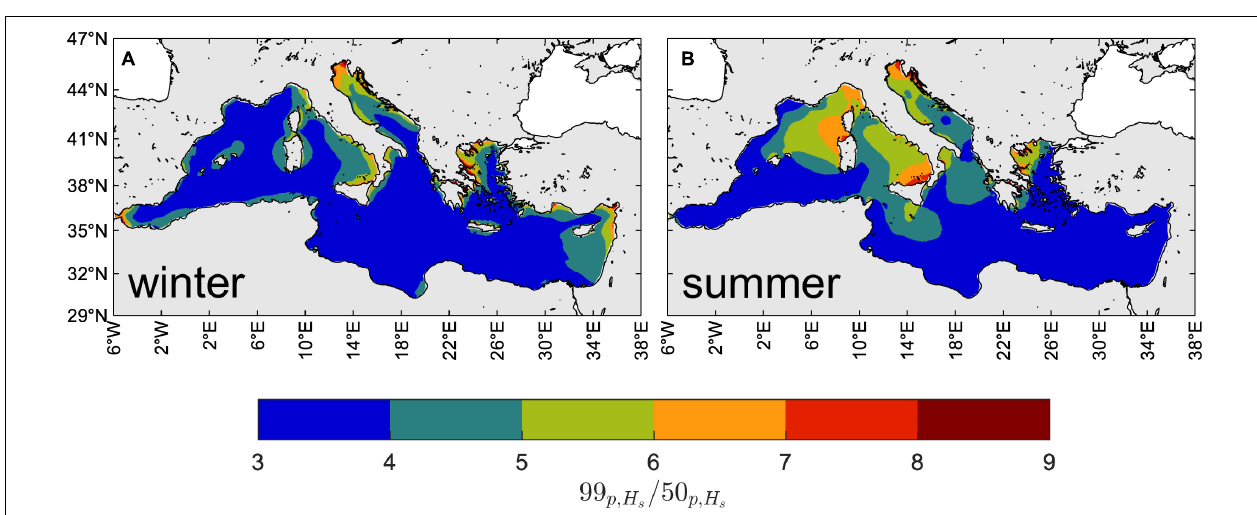
the southern part) off the eastern coast, as a consequence of the south-easterly Sirocco wind storms hitting the Croatia, Albany and Montenegro